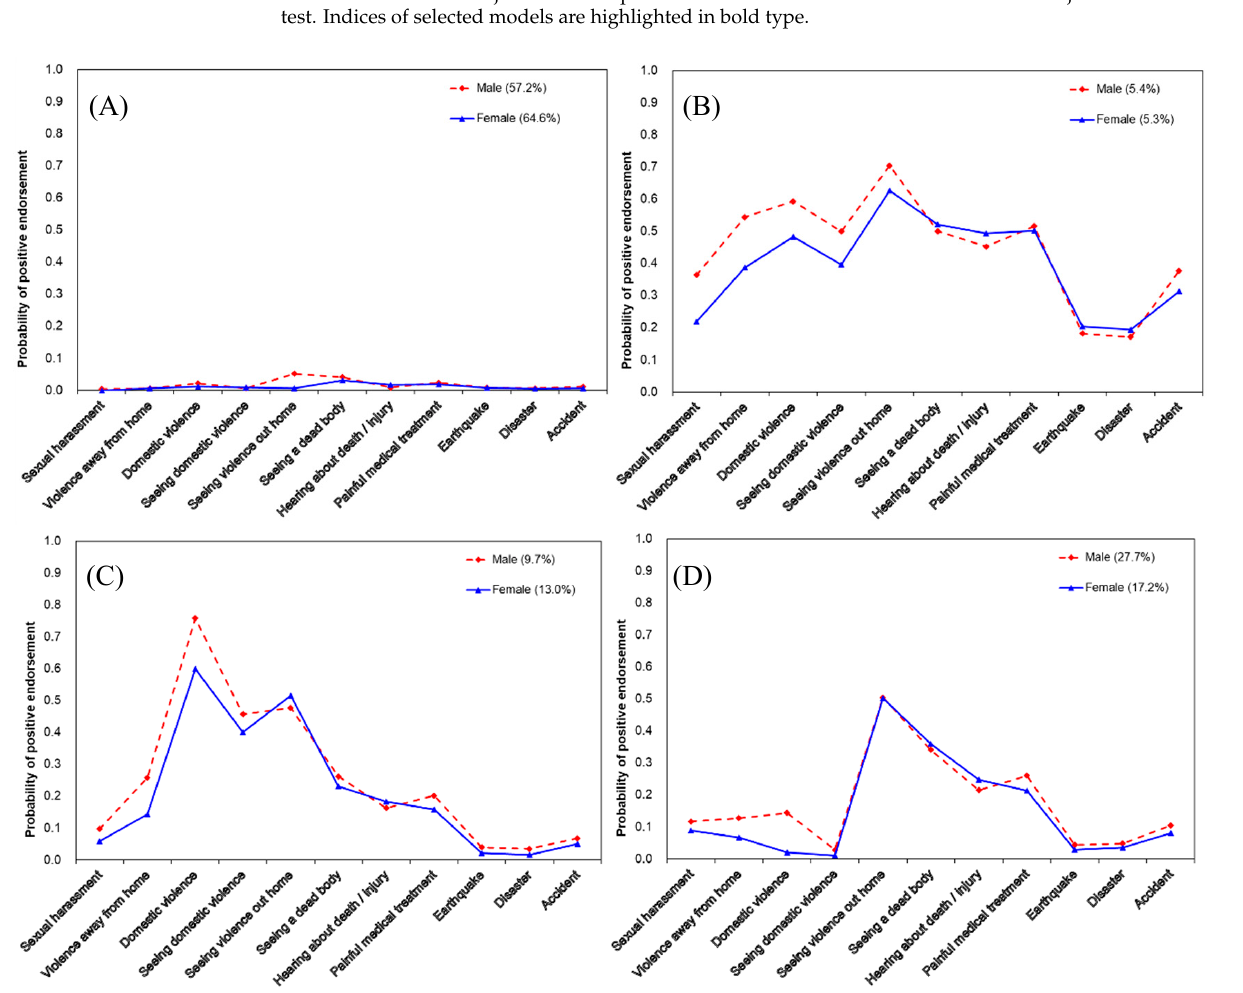
Figure 1. Four classes of childhood trauma in males and females: ( A ) Class 1: Low trauma exposure, ( B ) Class 2: Multiple trauma exposure, ( C ) Class 3: Domestic violence exposure, ( D ) Class 4: Vicarious trauma exposure.